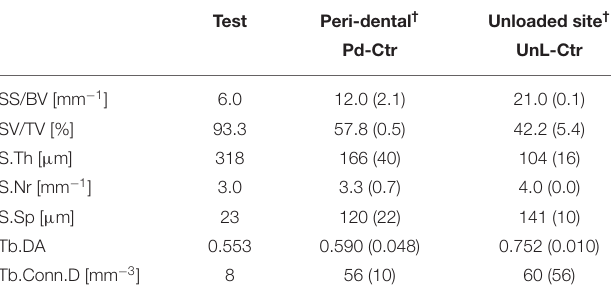
TABLE 2A | Study of microarchitecture in the test-maxillary biopsy (Test) retrieved after 7 years in-vivo : comparison with peri-dental bone microarchitecture (Pd-Ctr) and with unloaded bone control (UnL-Ctr).